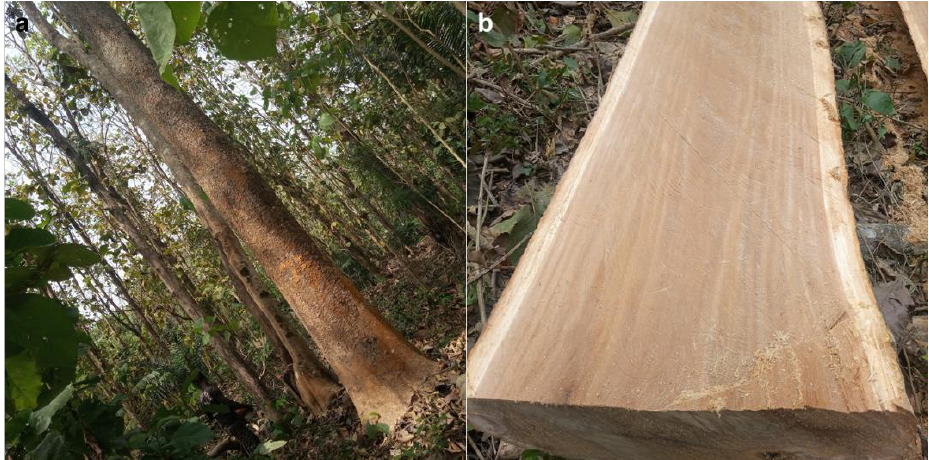
Figure 1. ( a ) Mixed plantation of gmelina and teak showing one of the harvested trees. ( b ) Halved stem of harvested gmelina with a thin band of sapwood.